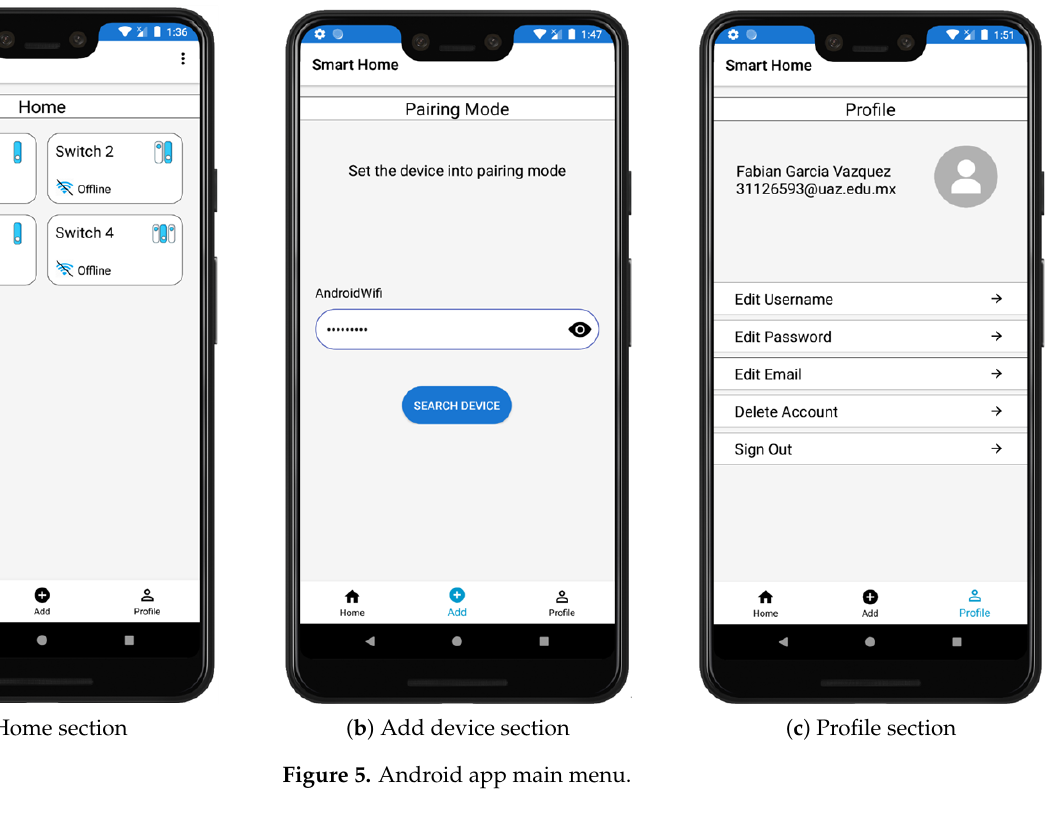
Figure 5. Android app main menu.